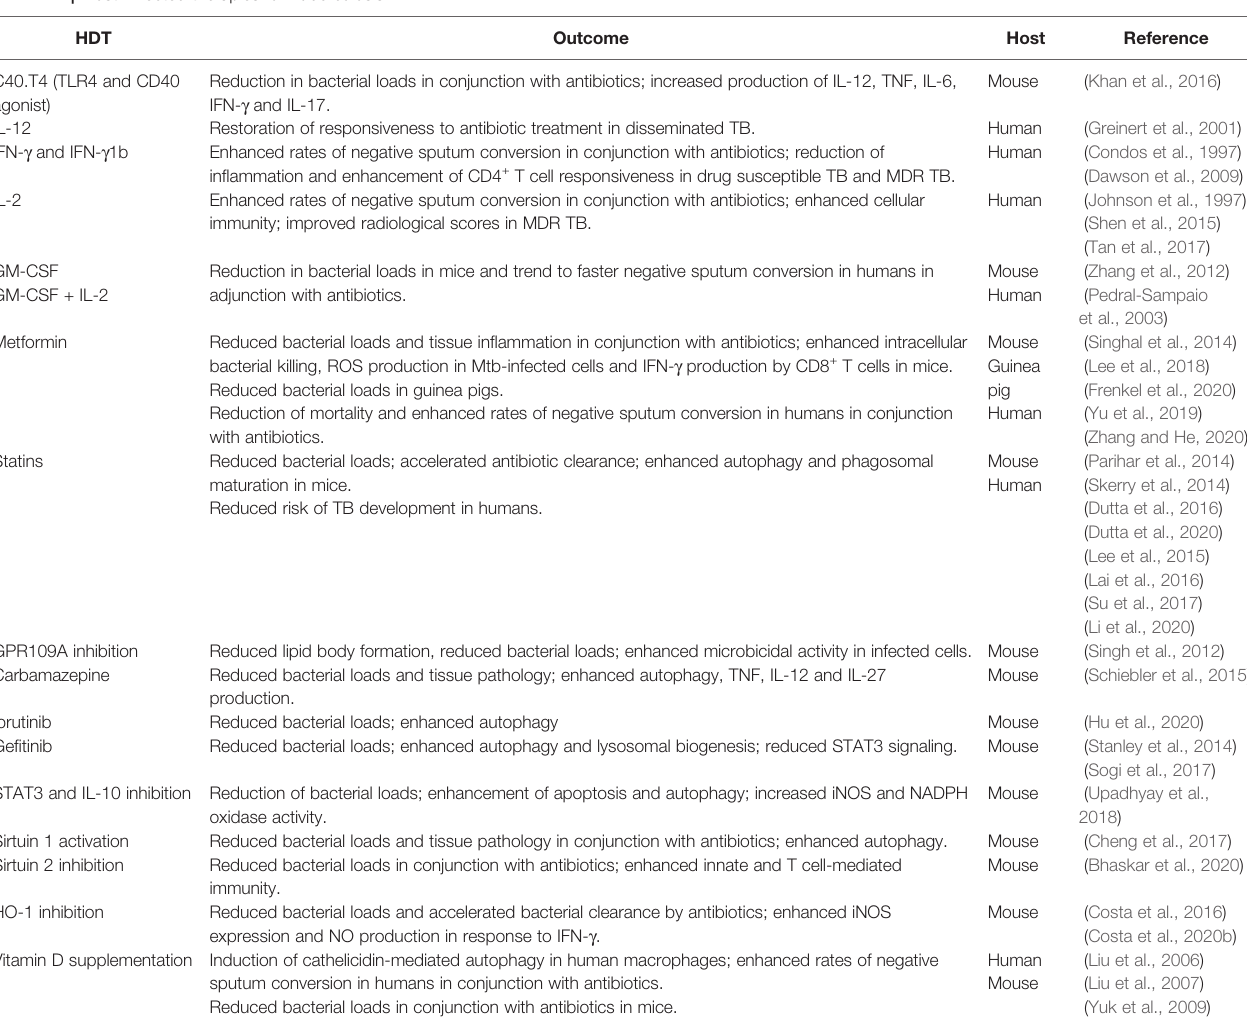
TABLE 1 | Host-Directed therapies for Tuberculosis.